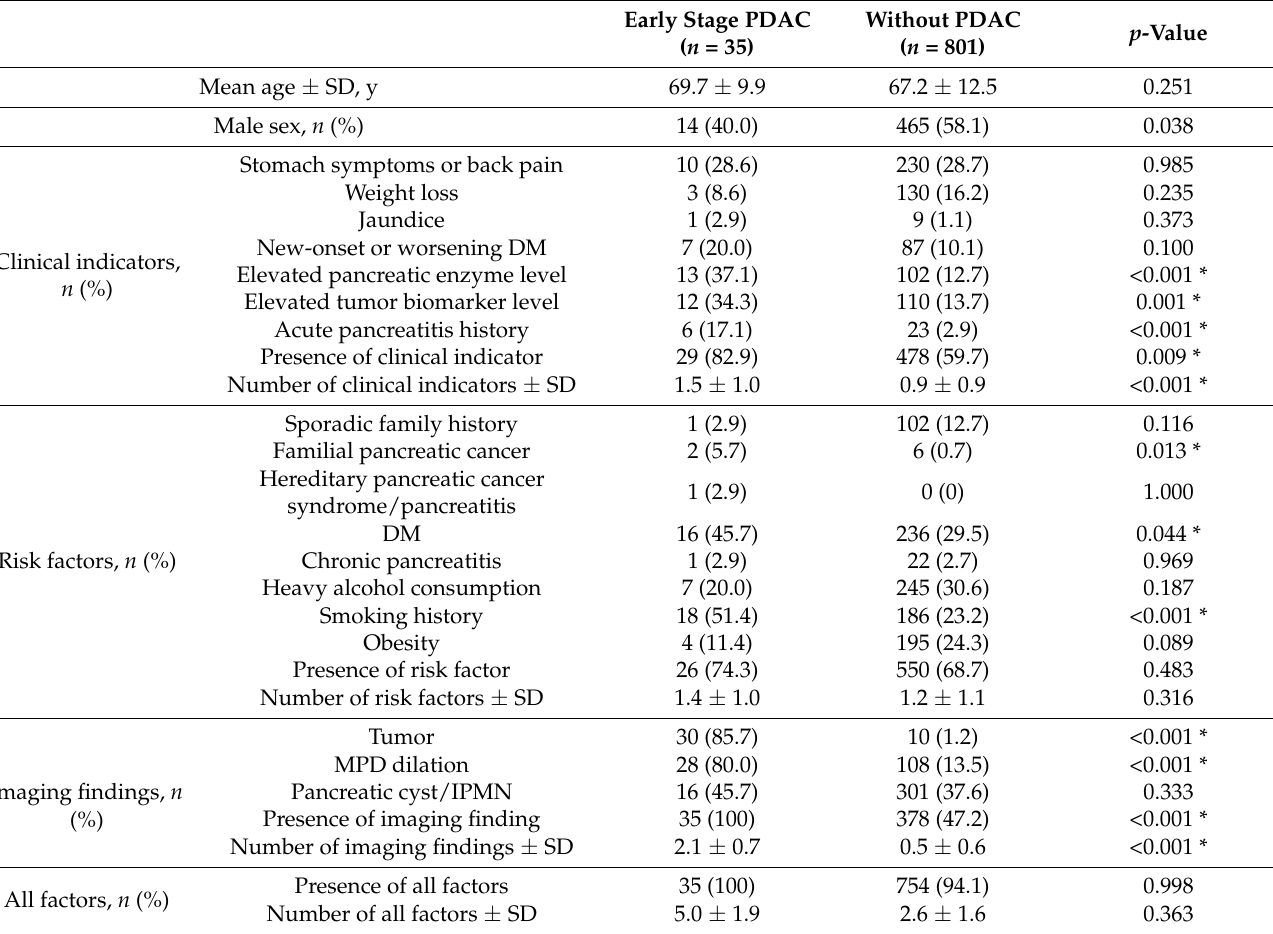
Table 2. Significant factors in the three categories for the diagnosis of patients with early stage